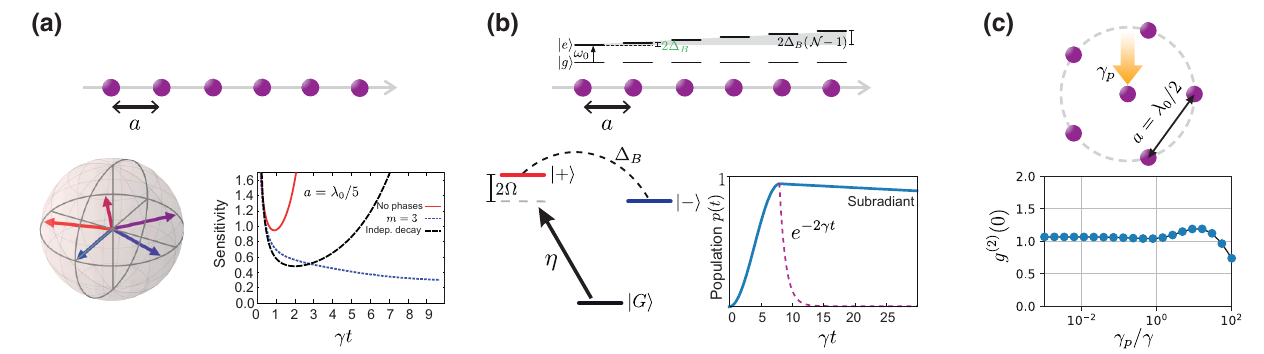
FIG. 7. (a) Ramsey metrology with phased excitation (shown on the individual spin Bloch sphere) for a chain of six emitters. Minimum sensitivity is plotted against interrogation time showing improved sensitivity for m = 3 (blue, dotted curve) as opposed to the independent case (black, dashed) or symmetric illumination (red, full line). (b) Phased excitation achieved via magnetic field gradient. For two coupled emitters, adiabatic population transfer to the robust state is achieved via detuned illumination of the symmetric state and subsequent transfer to the robust antisymmetric state via the magnetic field. The population reaches values close to unity and decays much slower than e − 2 γ t . (c) Subwavelength structure ( a = λ 0 / 2) of a ring resonator made of five quantum emitters surrounding an incoherently pumped central emitter. The second-order correlation function at zero delay g ( 2 ) ( 0 ) is presented as a function of the pumping rate γ p